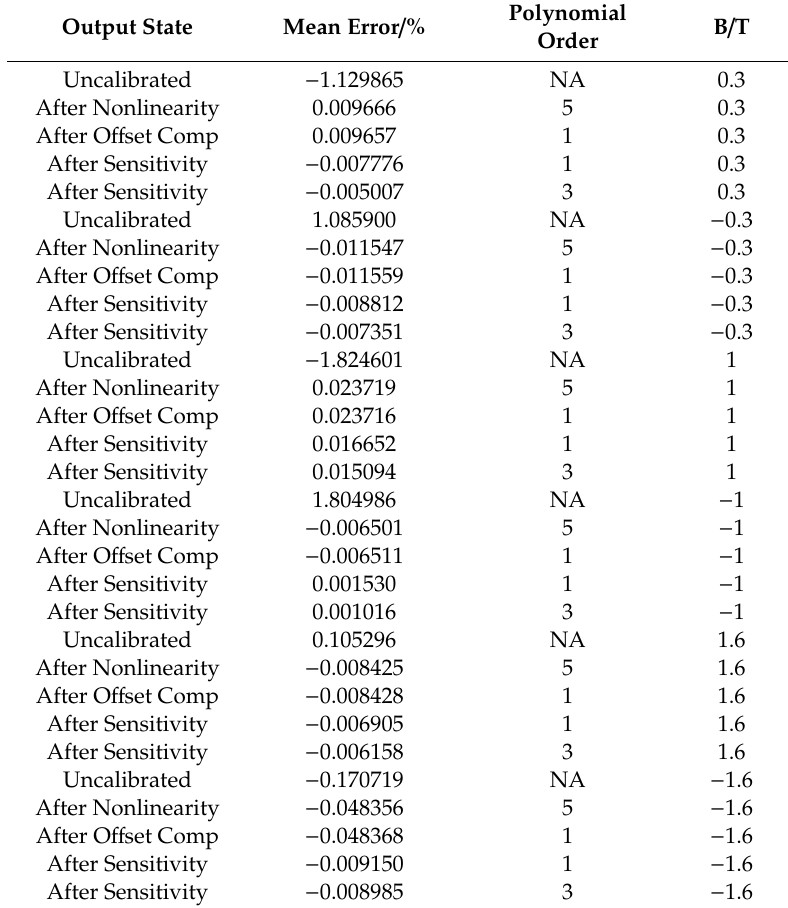
Table2. %meanerrorsobtainedatthedi ff